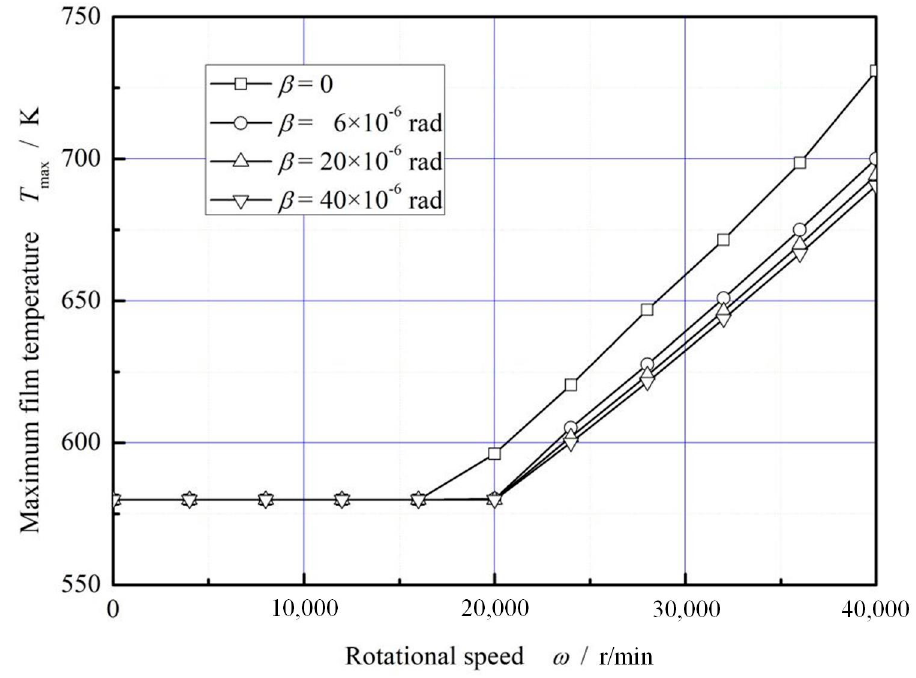
Figure 10. Influence of rotation speed on the maximum temperature of gas film. ( p i = 0.2 MPa, T in = 580 K, T out = 380 K).